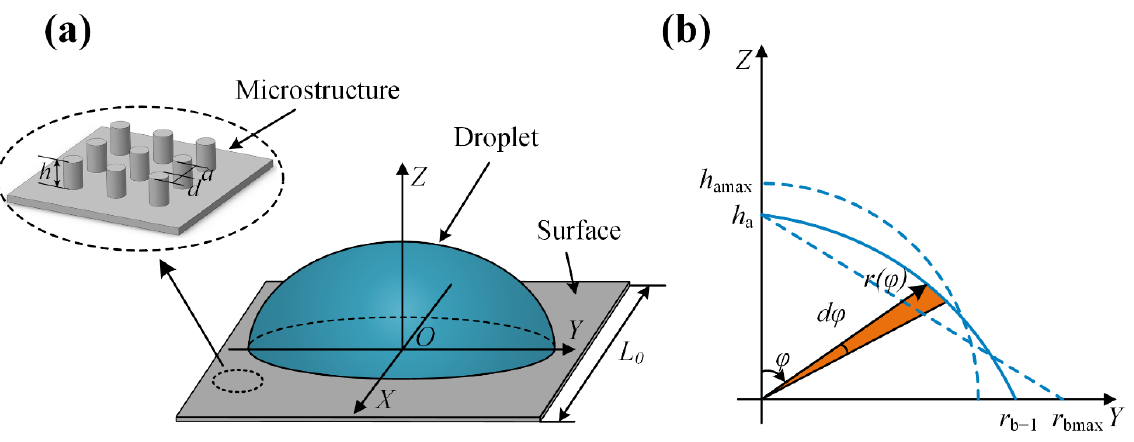
Figure 2. The sketch of calculation for the relative energy of the system E (cid:48) wmin − 1 . ( a ) A droplet stays on a horizontal rough surface decorated by circular pillars; h is the height of the pillar, d is the diameter of the pillar, and a is the periodic spacing of pillars. ( b ) A profile of the half-droplet; h a is the distance between the top of the droplet and the surface, h amax is the maximum h a , r b − 1 is the radius of contact circle on the surface, r bmax is the maximum r b − 1 , and ϕ 0 ≤ ϕ ≤ π is the angle between the radius vector r ( ϕ ) and the positive z -axis.